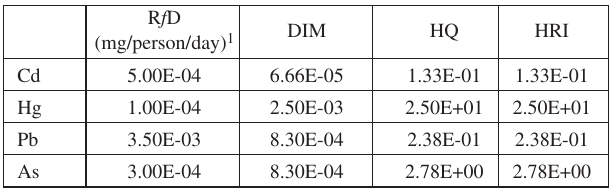
Table 3. Food reference doses, HRI, DIM and HQ calculated for examined Hungarian apricot